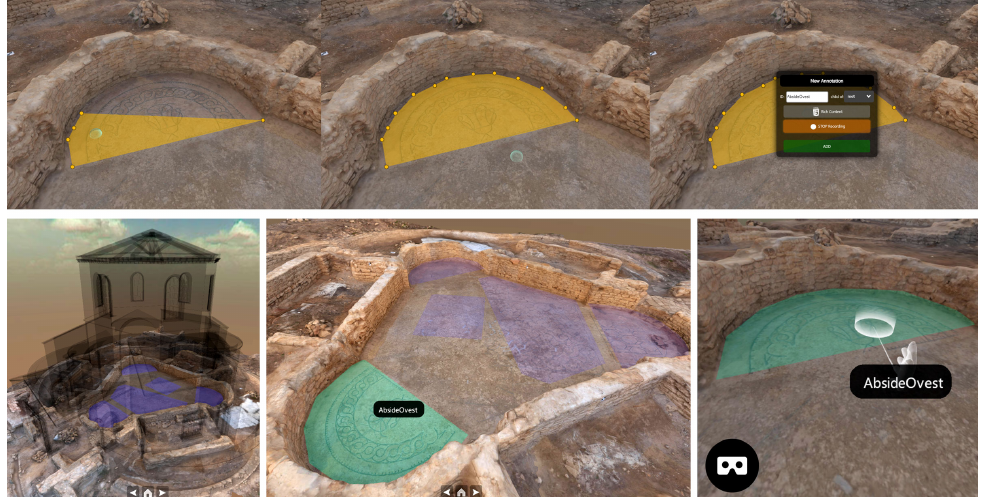
Figure 20. Top row : vocal annotation workflow: free-form shape annotation of the floor decoration, new annotation ID and voice recording. Bottom row : the Aiano 3D scene with audio playback on user activation of annotated areas, from PC and HMD (Oculus Quest) using VR controllers.